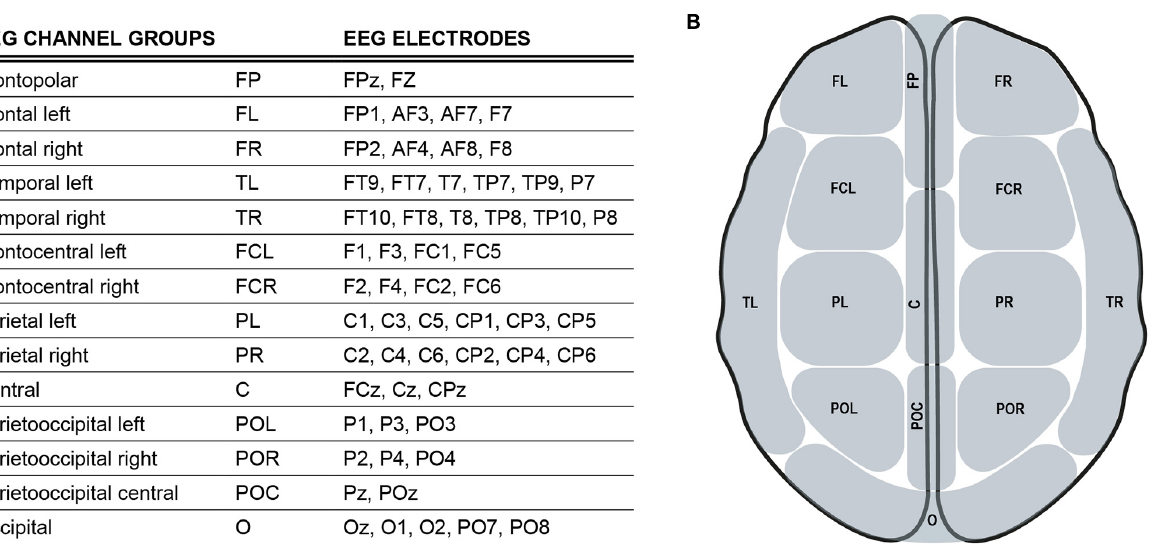
FIGURE 2 | EEG channel groups (A), an overview of EEG channels and their assignment to regional channel groups. (B) Simplified scheme of EEG channel groups defined in 2 (A) .